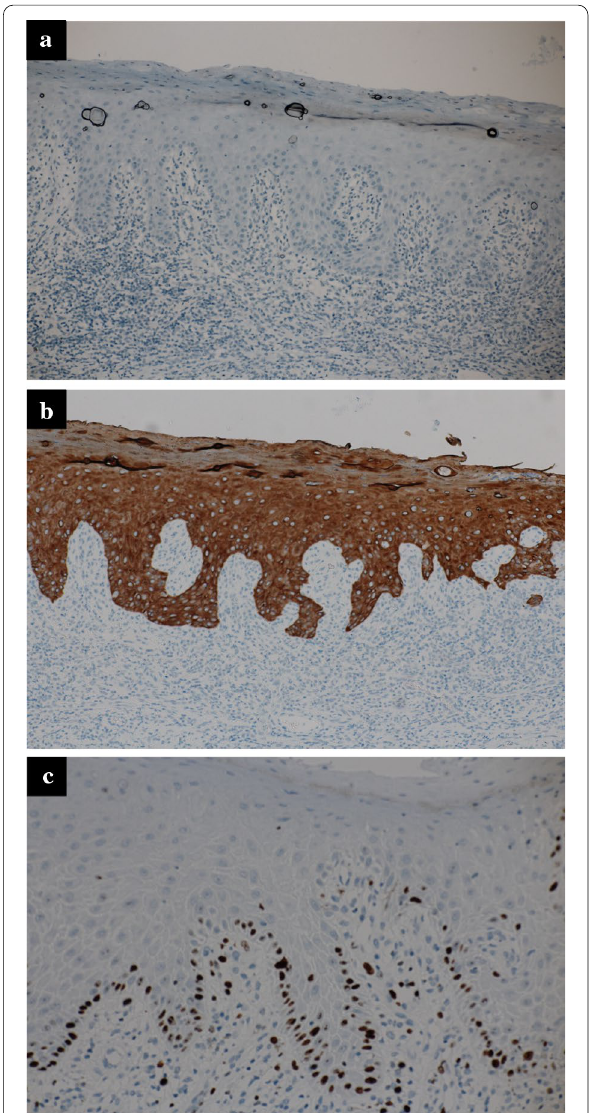
Fig. 7 Intraoperative view. a Designated incision line (solid line: band-shaped indurated mucosal excisional area; dotted line: incision line for double Z-plasty flaps). b Results after Z-plasty. c Diagram of the double Z-plasty